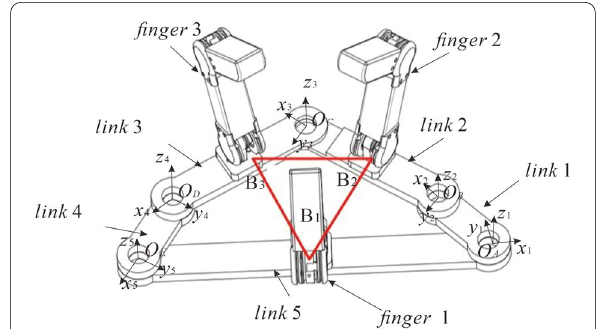
Figure 1 Workspace triangle of the metamorphic hand